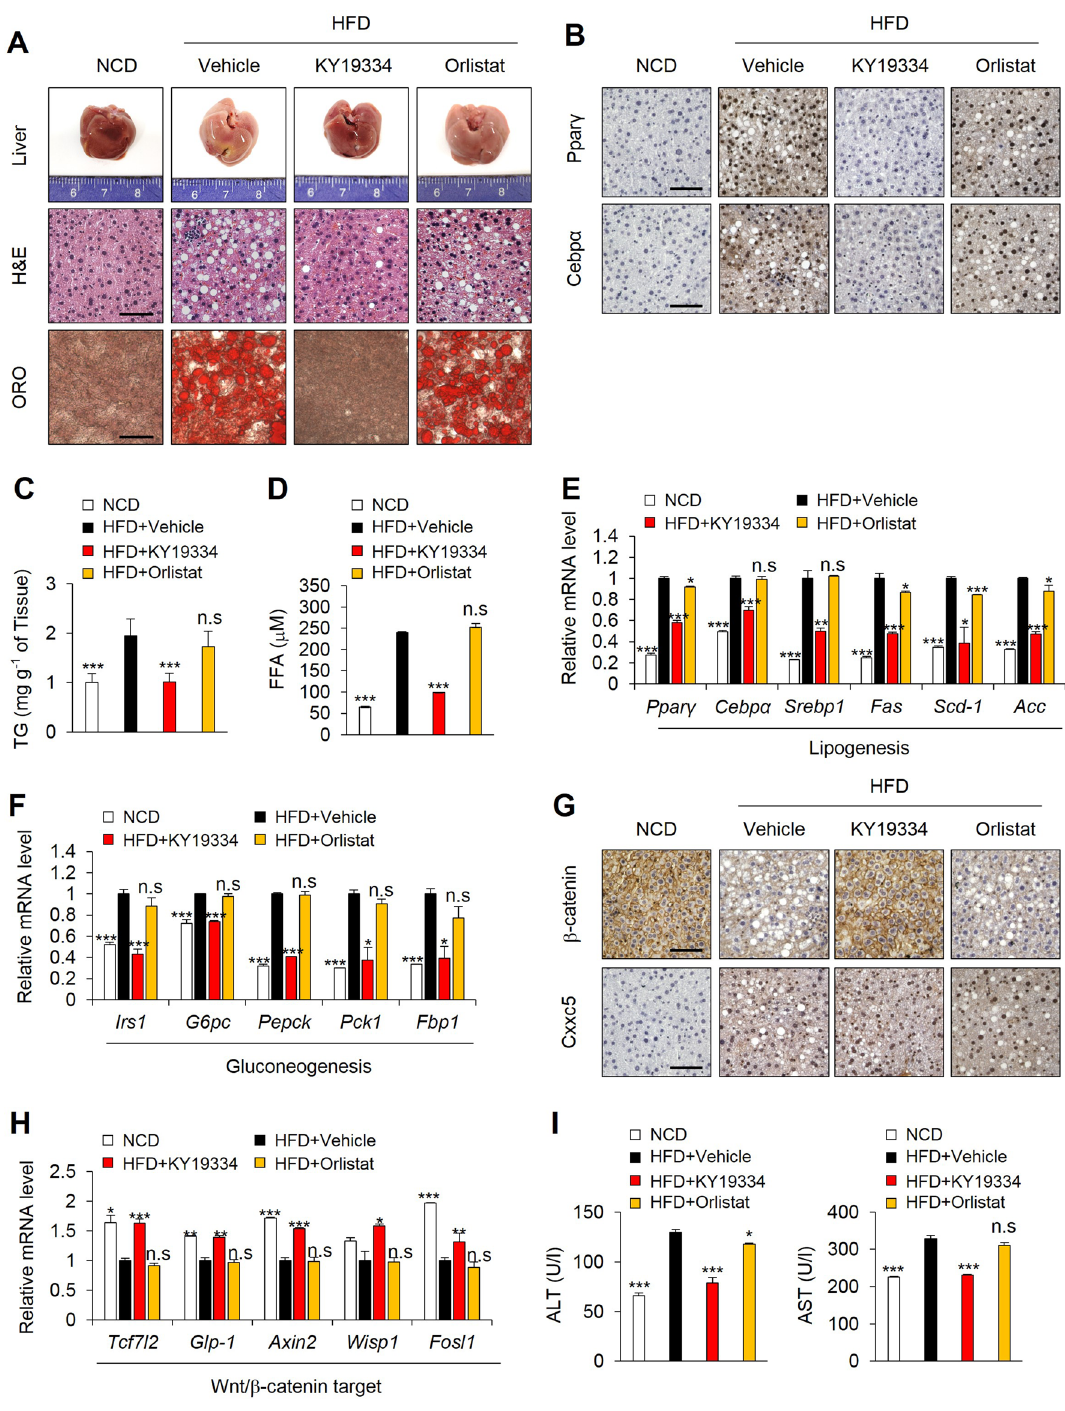
Figure 5. KY19334 treatment prevents hepatic steatosis and improves glucose homeostasis. C57BL/6 mice fed the NCD or HFD were administered as described in the legend of Fig. 2. ( A ) Representative images of liver, H&E staining, and Oil Red O staining. ( B ) Representative images of Pparγ and Cebpα immunohistochemistry of liver. ( C ) TG concentration in liver tissues. ( D ) Plasma concentration of FFA. ( E , F ) Relative expression levels of marker genes for lipogenesis ( E ) and gluconeogenesis ( F ) ( n = 3 per group). ( G ) Representative images of β-catenin and Cxxc5 immunohistochemistry of liver. ( H ) Relative expression levels of marker genes for Wnt/β- catenin target. ( I ) Plasma concentration of ALT and AST. Scale bar, 100 µm. Results are expressed as mean ± SD., n = 3 per group, * P < 0.05, ** P < 0.01, *** P < 0.001, n.s indicates non-significance with HFD-fed vehicle group. NCD normal chow diet, HFD high-fat diet, TG triglyceride, FFA free fatty acid, ALT alanine transaminase, AST aspartate